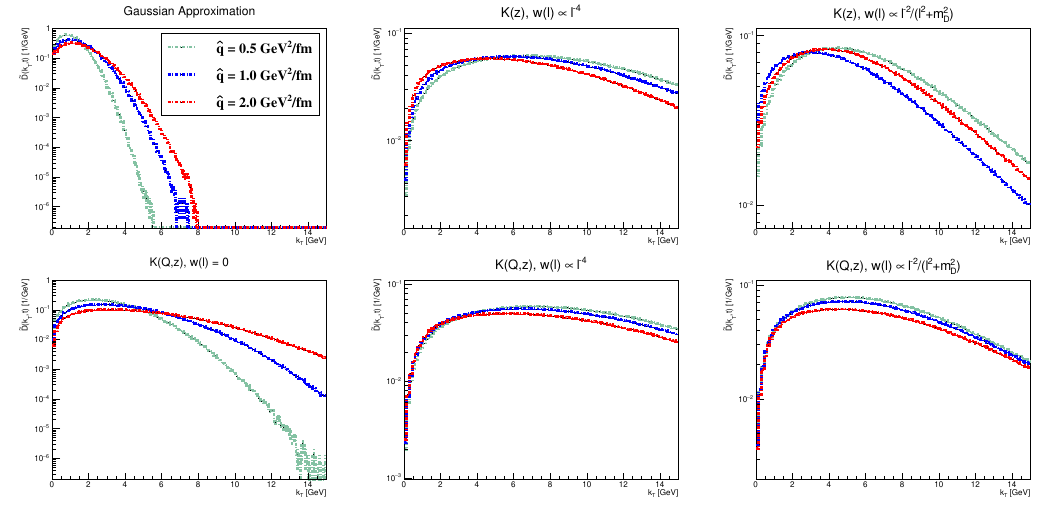
Figure 6 . The k T distributions for ˆ q = 0 . 5 , 1 , 2 GeV 2 / fm and t = 4 fm.